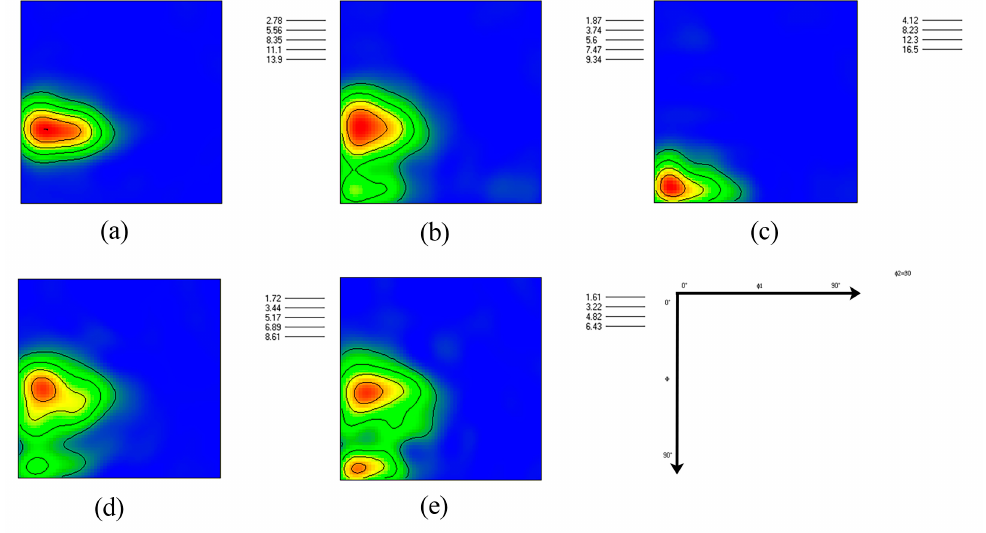
. ε = 1 × 10 − 2 s − 1 : ( a ) 300 ◦ C;